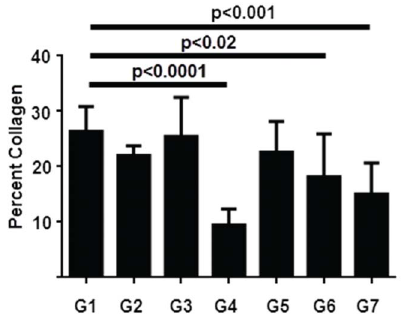
Figure 5. Graphical representation of the percentage Sirius red positive tissue from experiment described in Figure 4. Statistical analysis performed was One Way ANOVA followed by Dunnett’s multiple comparison testing to compare each group separately to group 1. Mean values, standard deviation, and adjusted p values are shown.